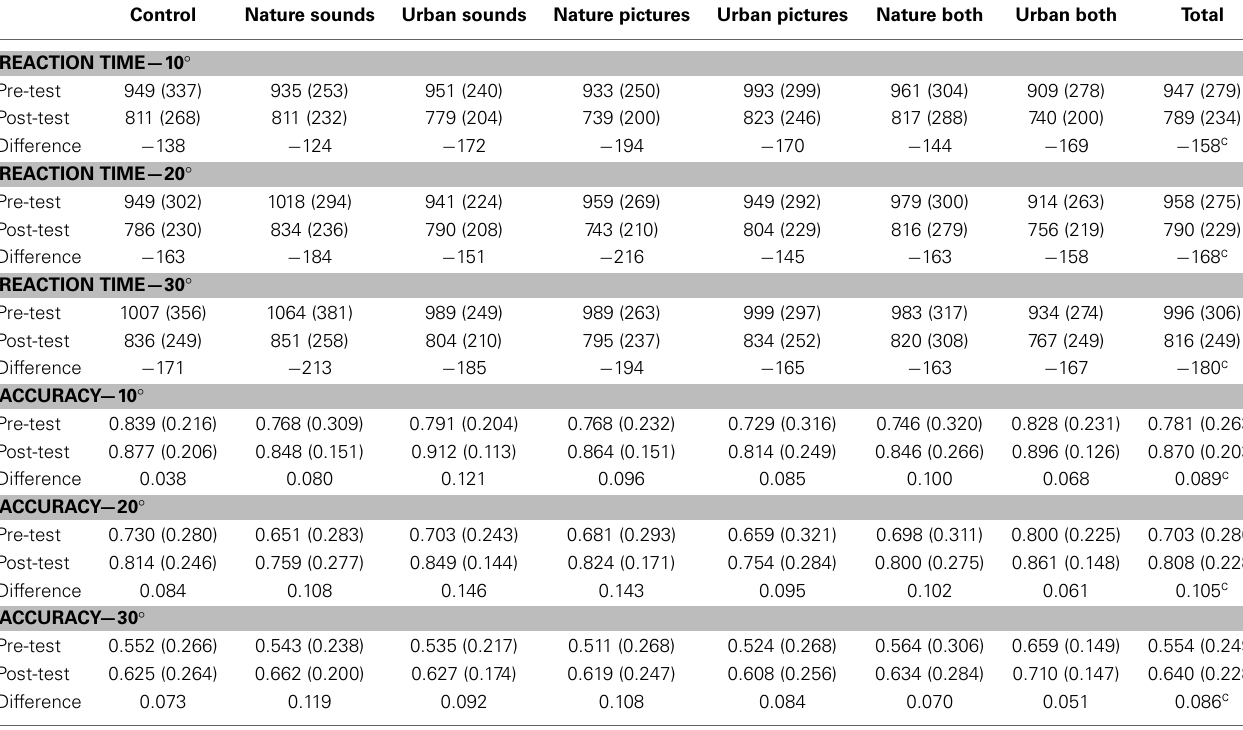
Table 5 | Reaction time and accuracy for all conditions on the functional field of view